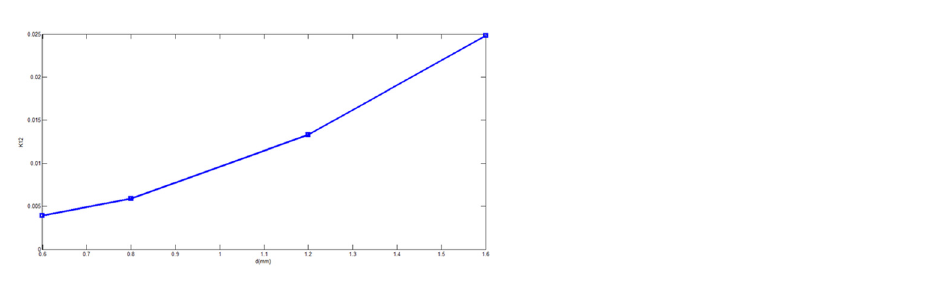
Fig 15. Coupling coefficient K12 as function of d.